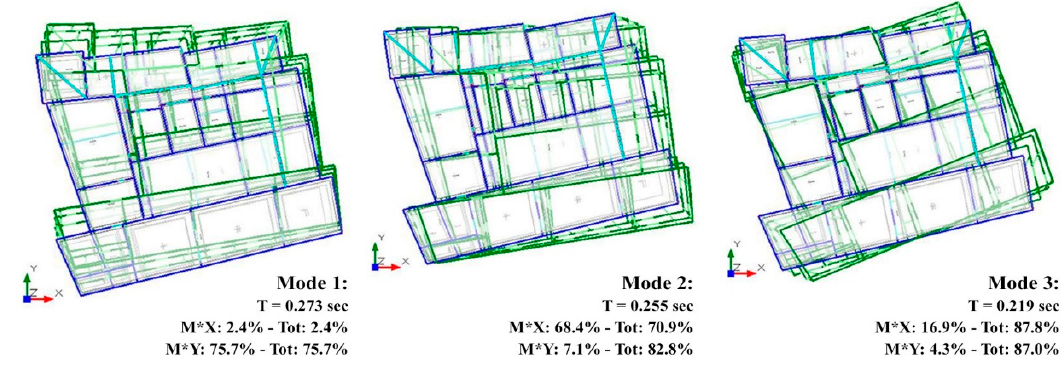
Figure 17. The first three vibration modes of the case study structure. Table 3. Safety indices obtained for the ultimate limit state ( α ULS,PGA ) and the damage limit state ( α DLS,PGA ).